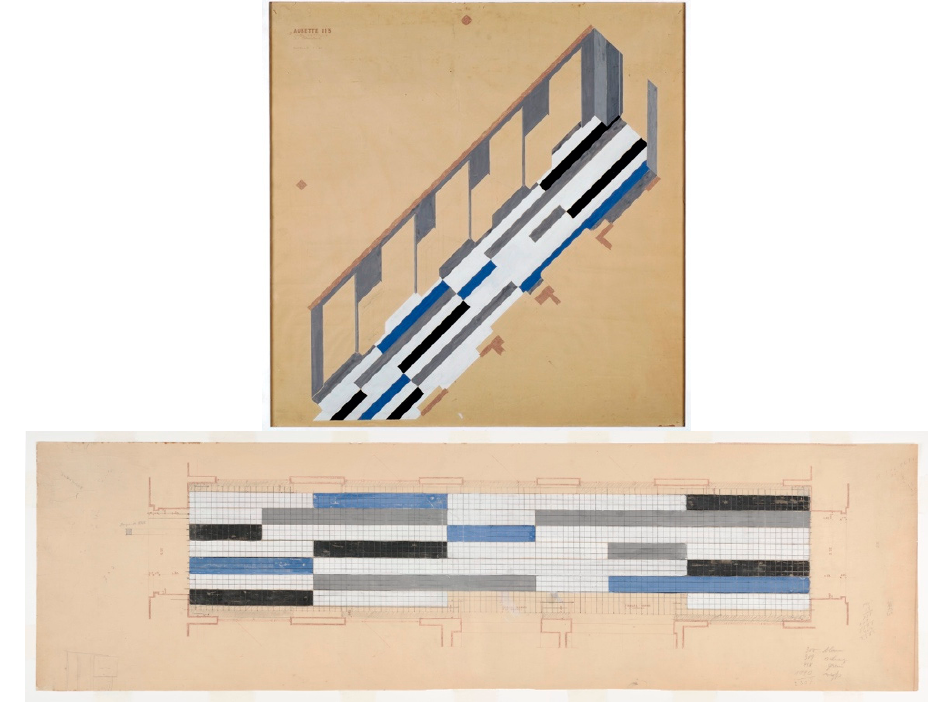
Figure 17. Sophie Taeuber-Arp, Aubette 113, 1927. Pencil and gouache on paper. Musée d’Art Moderne et Contemporain de Strasbourg, used by permission.